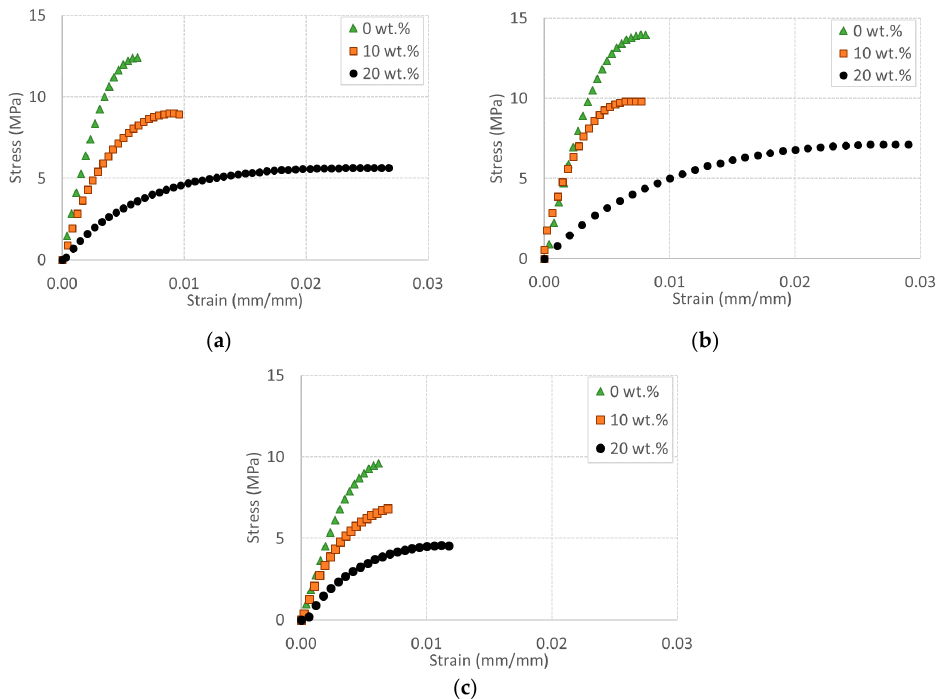
Figure 2. Stress vs. strain for all materials extruded in conditions of ( a ) starve feeding, ( b ) flood feeding at 25 RPM, and ( c ) flood feeding at 100